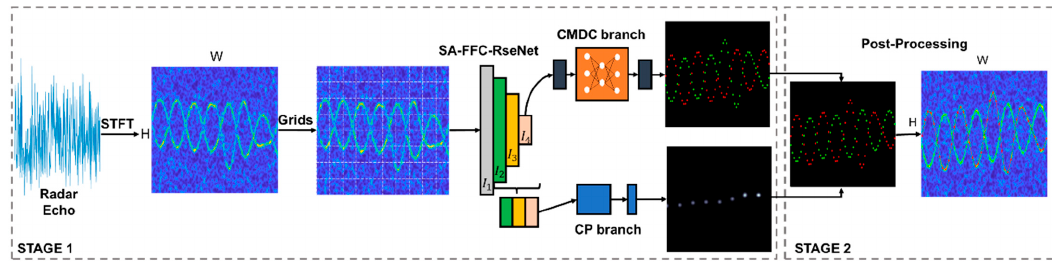
Figure 5. Overview of the proposed method.